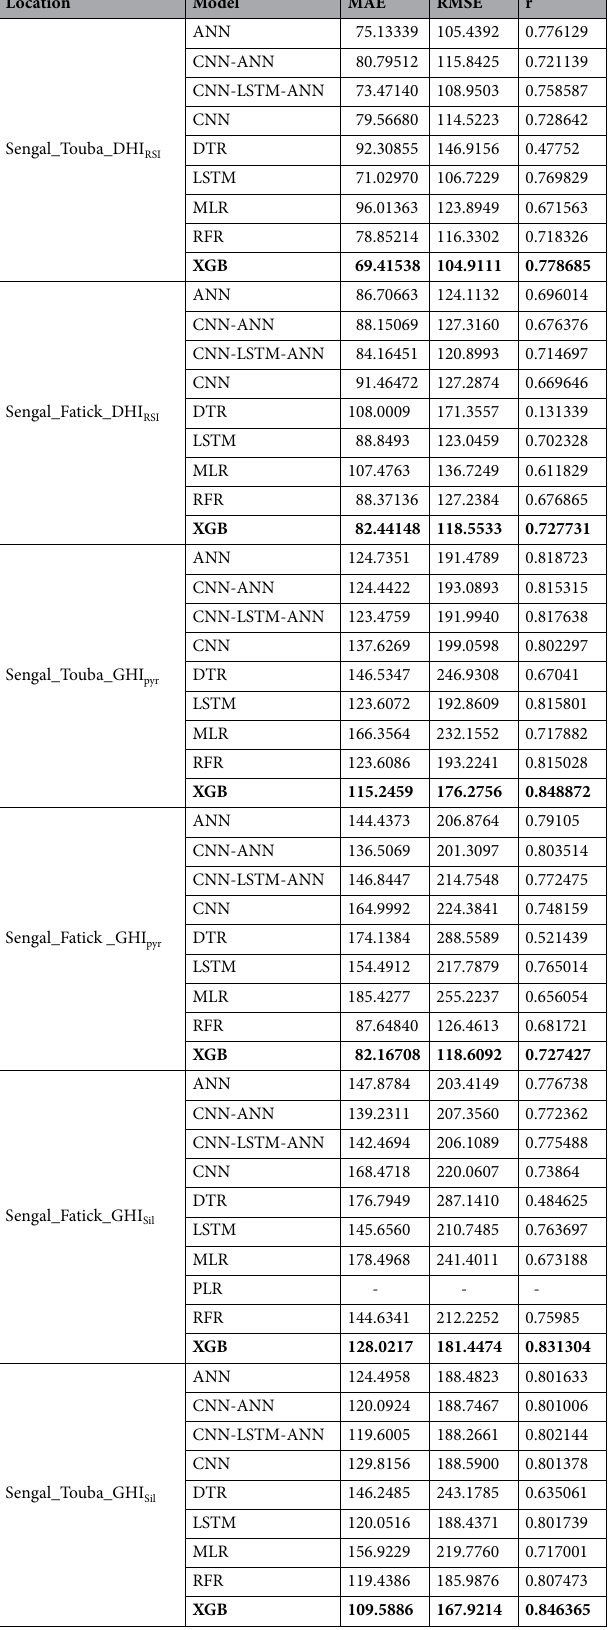
Table 9. Minutes timestep SR task evaluation metric summary. Significant values are in